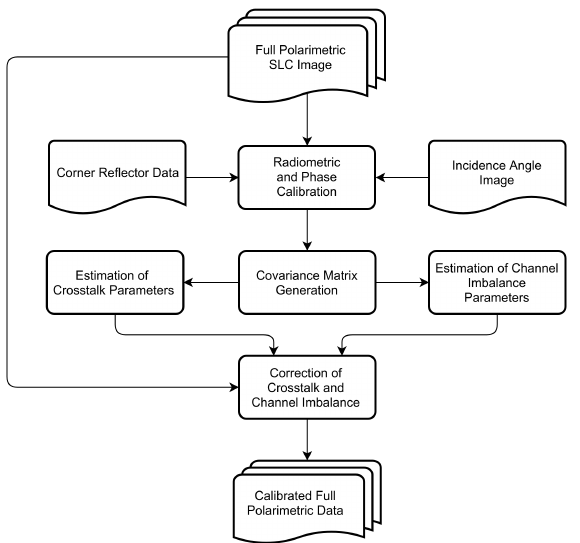
Figure 1. The research